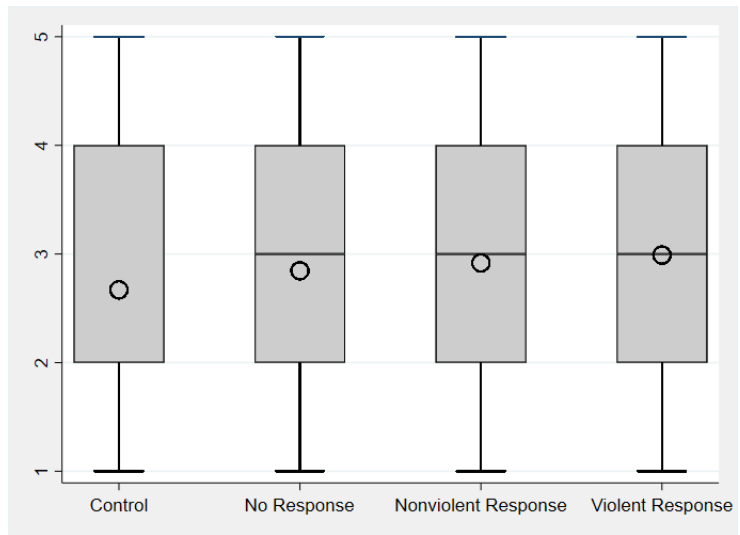
Figure 1. The causal effects of persecution discourse on perceptions of threat to religious liberty across conditions (full sample). Key : boxes represent the interquartile range; circles represent the mean; thick lines represent the median; whiskers represent minimum and maximum values.